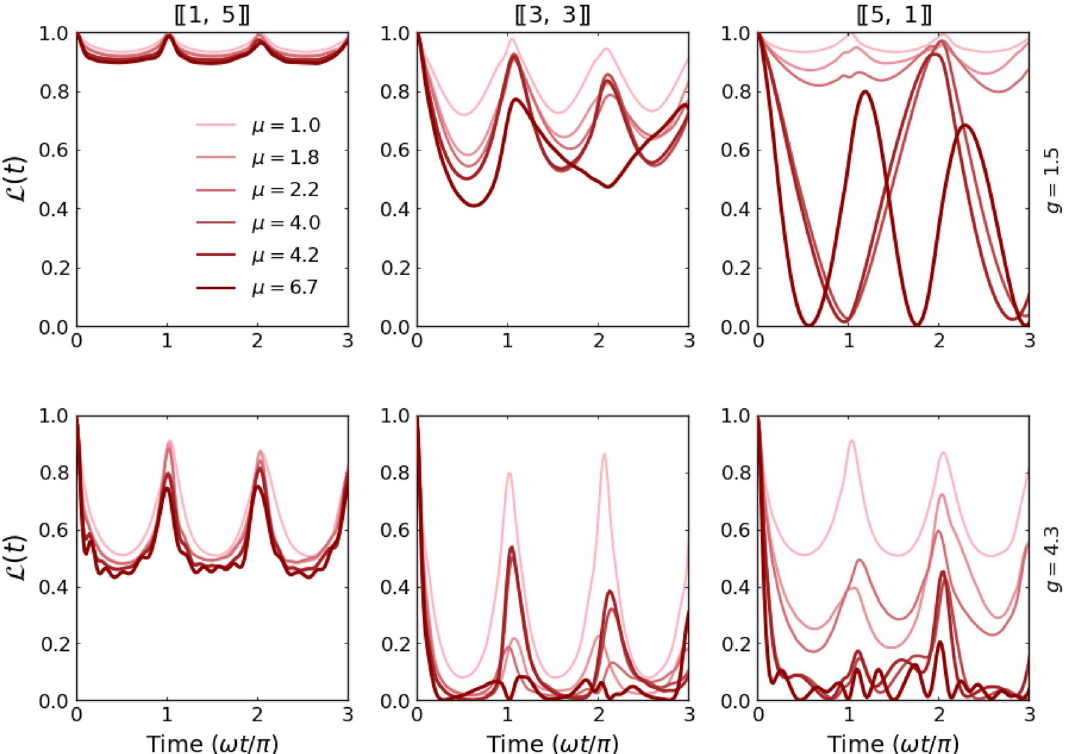
6 particles and =